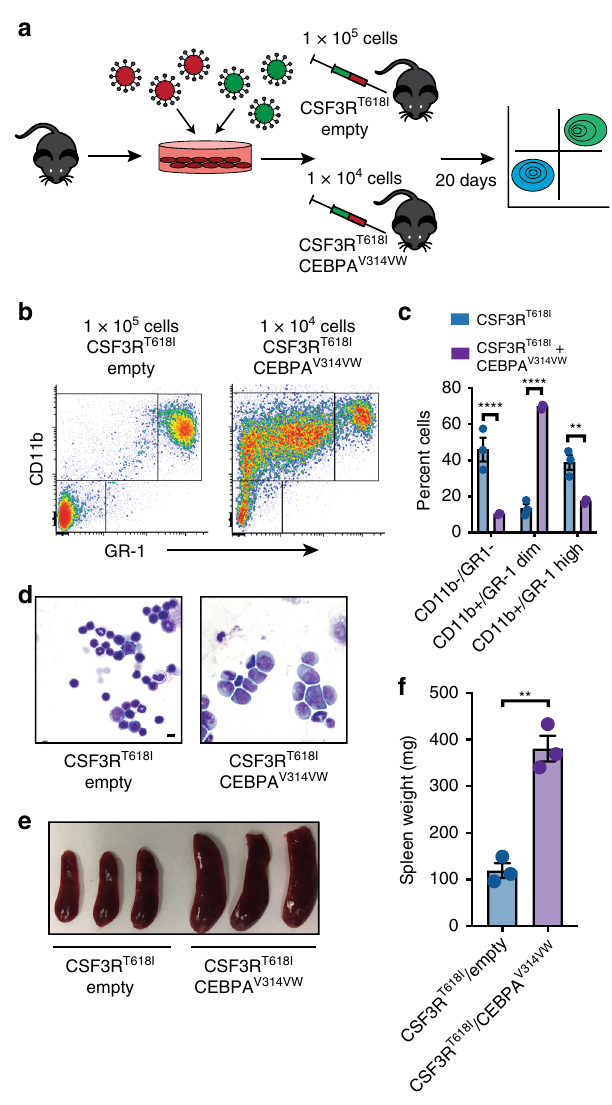
Fig. 4 CEBPA mutations block differentiation in response to mutant CSF3R. a Experimental strategy to directly compare the differentiation of cells harboring CSF3R T618I and CSF3R T618I /CEBPA V314VW . b Bone marrow fl ow cytometry comparing myeloid differentiation markers in mice transplanted under conditions in a . c Quanti fi cation of populations in b . d Example bone marrow histology from mice transplanted in a (scale bar represents 10 μ m). e Spleens from mice in a . f Spleen weights from mice in a . Values are represented as mean with error bars representing SEM. Signi fi cance of comparisons assessed by Students T -test or ANOVA with Sidak post-test as appropriate ** p < 0.01, **** p < 0.0001. Source data are provided as a Source Data fi